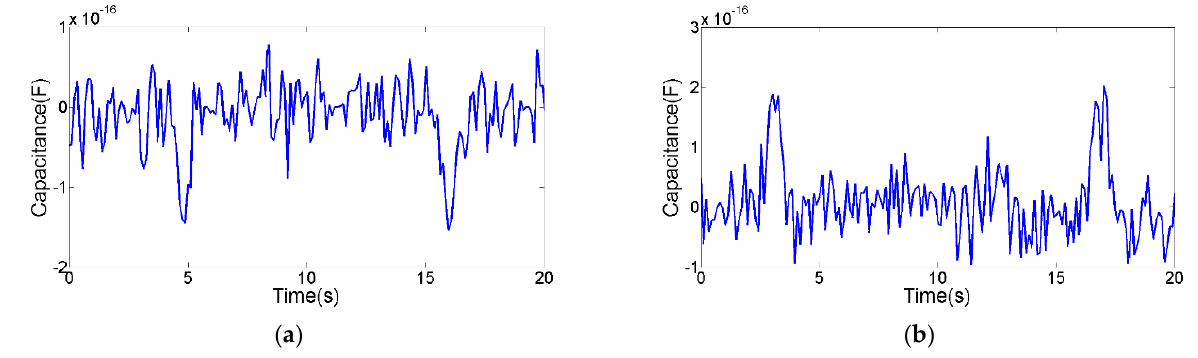
Figure 12. The detection floor level of capacitance parameter. ( a ) The capacitance signal of 160 µ m air bubble, ( b ) the